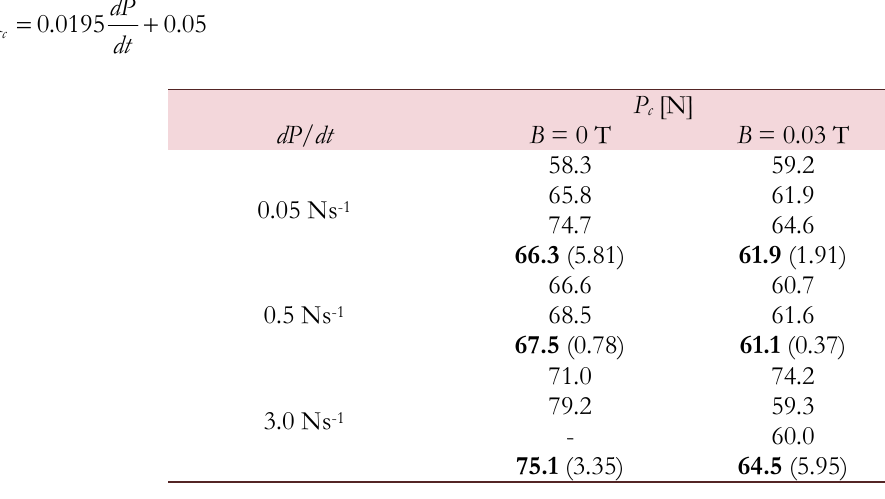
Table 3: Measured fracture loads as a function of the loading-rate and the magnetic field